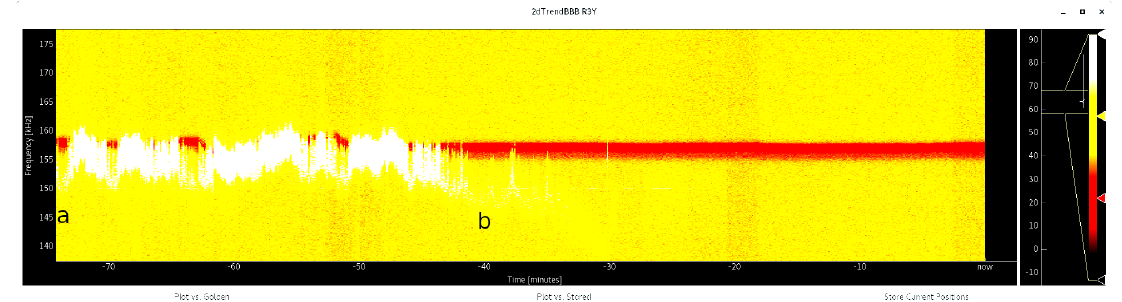
Figure 7. Accelerator tunes visualization in the 3 GeV storage ring. Between − 80 (point “a”) and − 40 min (point “b”), a disturbance can be seen around the tune frequency. At –40 min, a faulty amplifier connected to a tune measuring system was turned off. This vertical disturbance caused an increase in vertical emittance, which decreased to nominal values as soon as the disturbance moved away from the tune